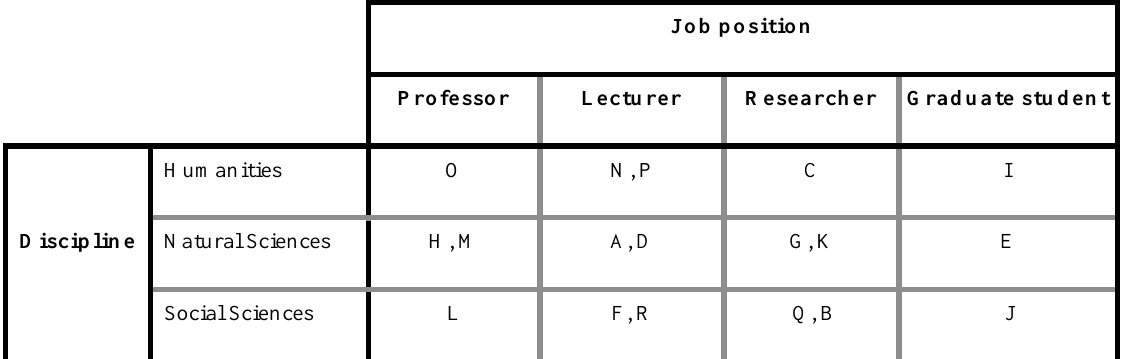
Pseudonym Initials Assigned to Interview Participants, Cross Tabulated by Job Position and Discipline